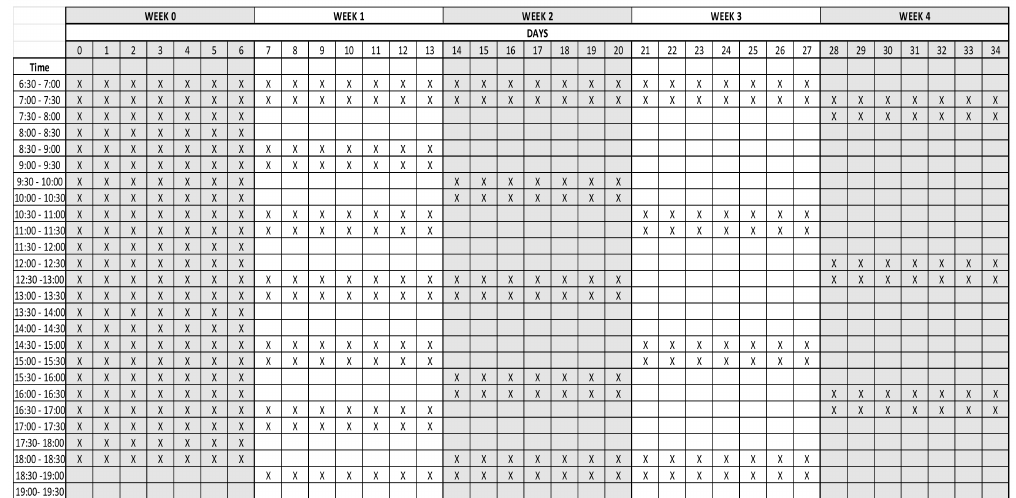
Figure A1. Timetable depicting the presence (marked with an X) / absence (space left empty) of human with the experimental chicks from day old (day 0) to three months of age (day